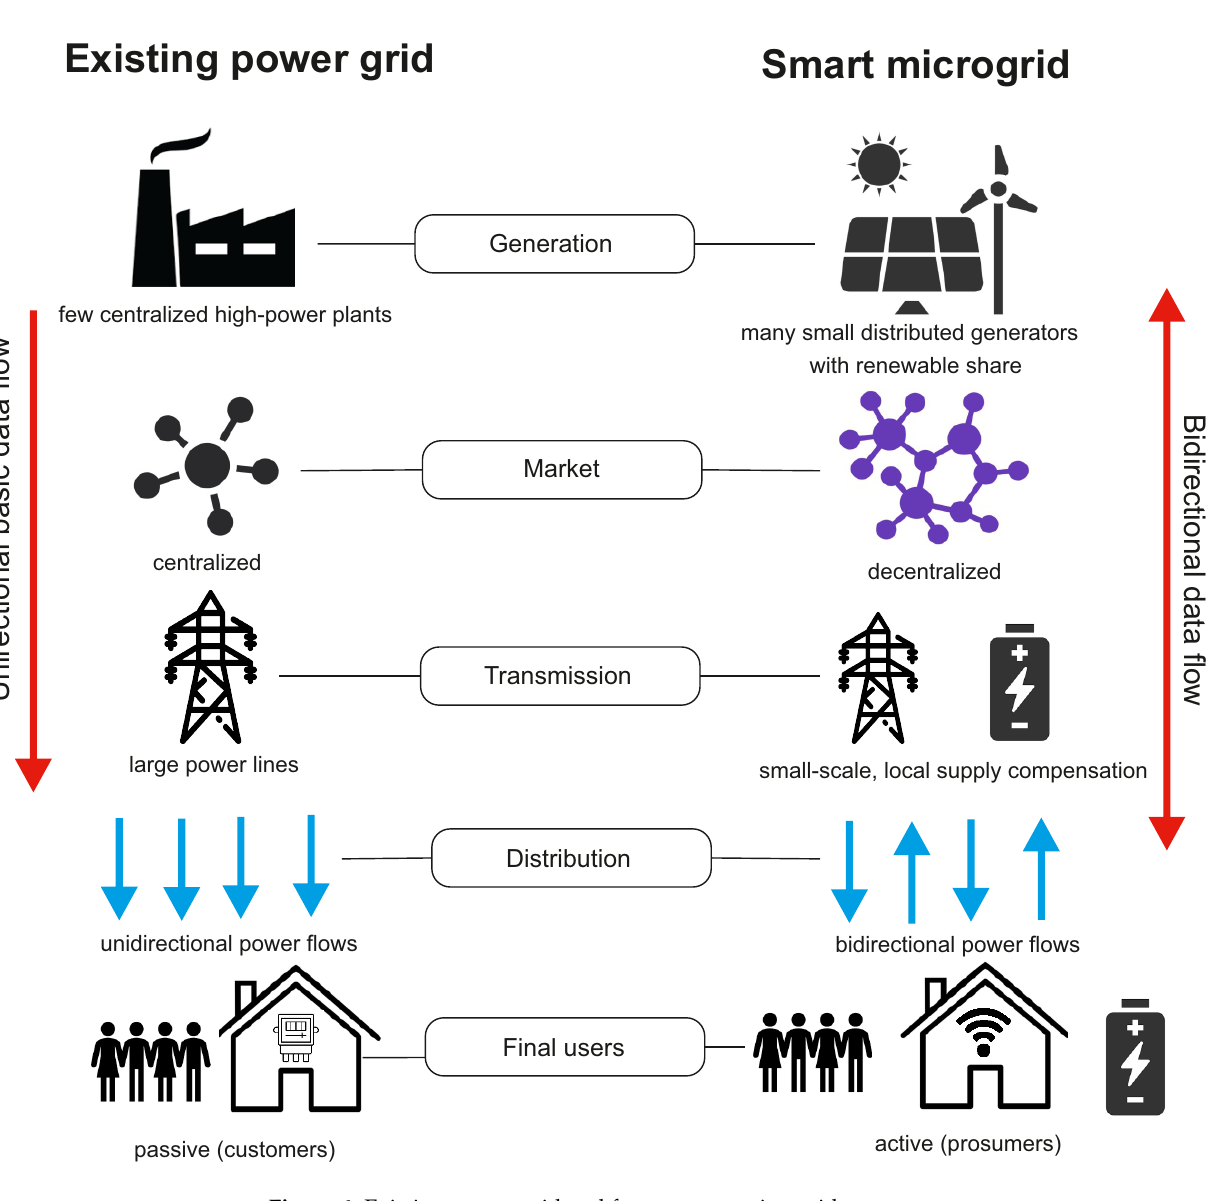
Figure 6. Existing power grid and future smart